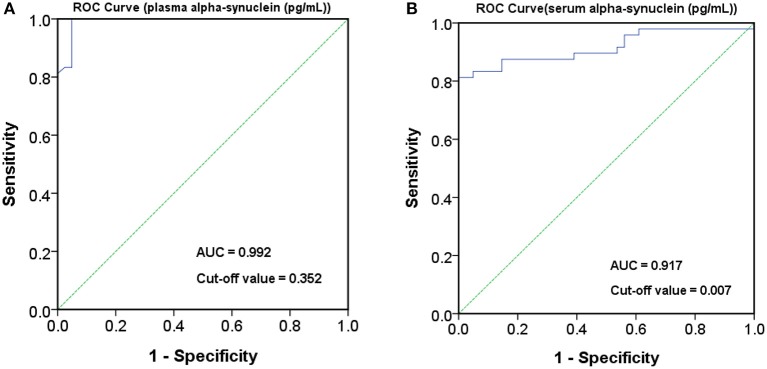
Receiver operating characteristic (ROC) curve for plasma and serum α-synuclein levels to detect Parkinson's disease (PD). ROC curves of plasma (A) and serum (B) α-synuclein levels for distinguishing PD patients from healthy controls (HCs). AUC, area under the ROC curve.